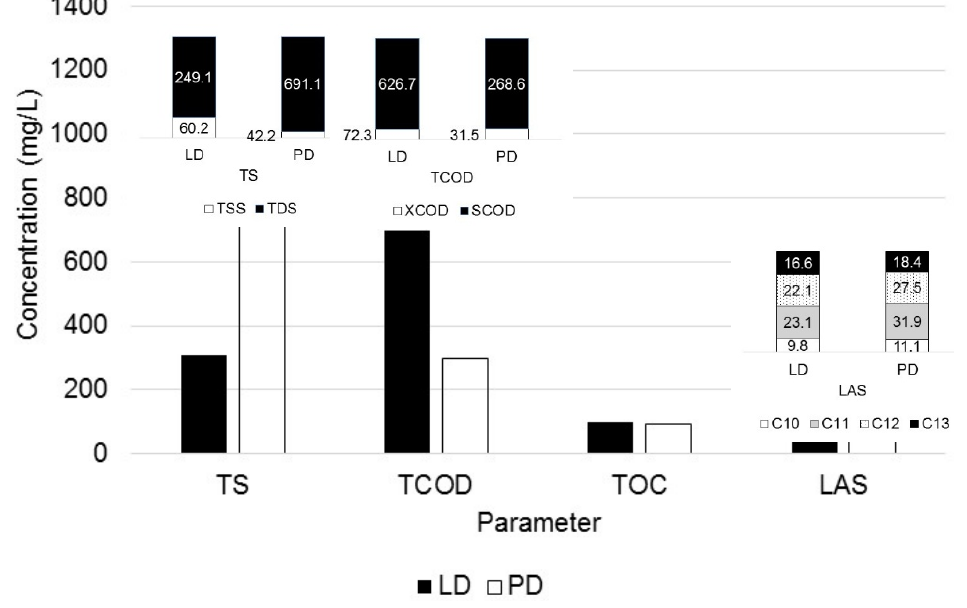
Figure 1. Composition of liquid (LD) and powder detergent (PD) in recommended dosages. TS: total solids; TCOD: total chemical oxygen demand; TOC: total organic carbon; LAS: linear alkylbenzene sulfonates.